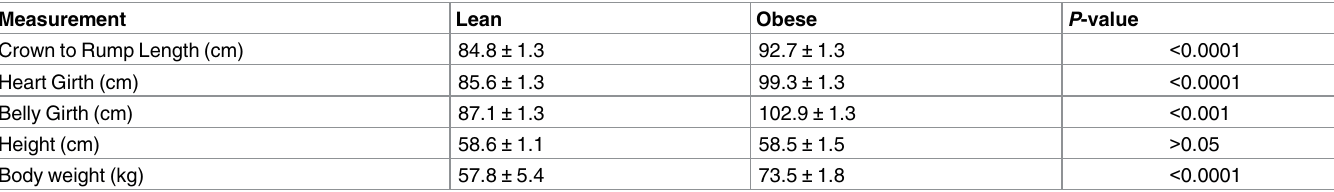
Table 1. Morphometric measurements for lean and obese Ossabaw